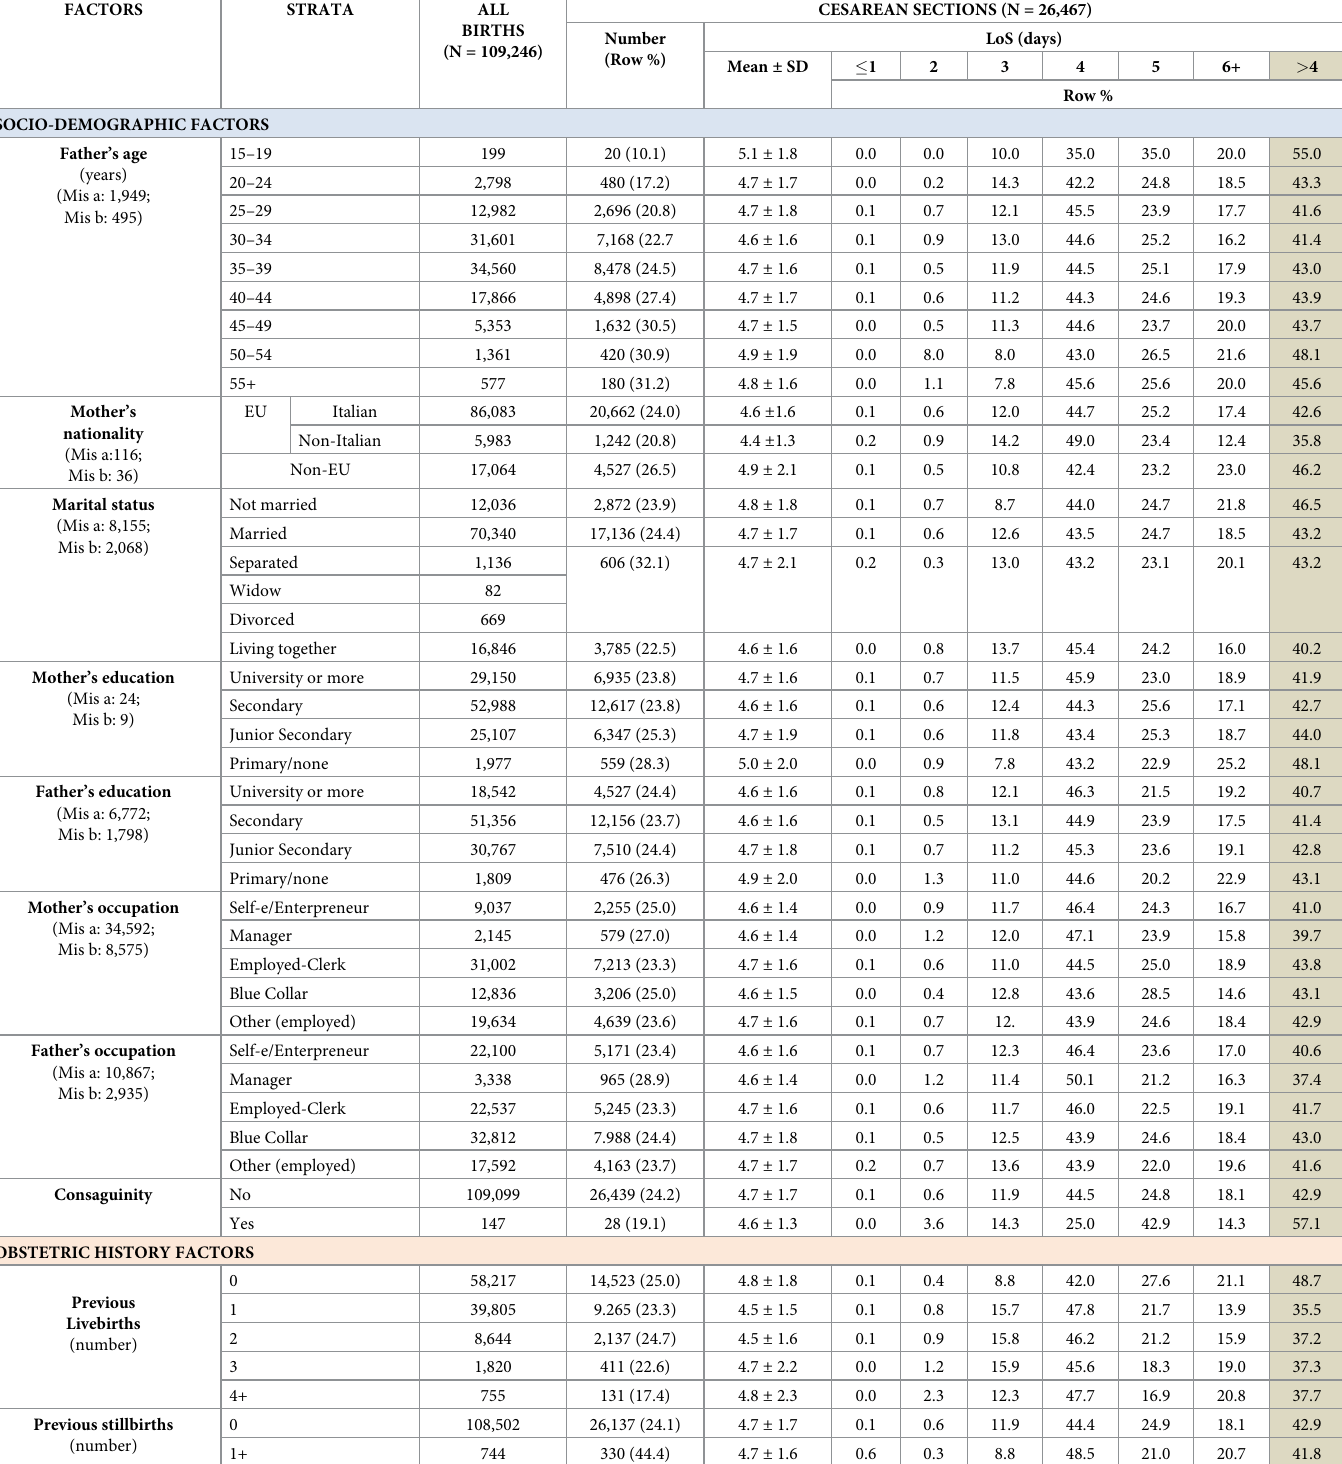
Table 4. Distribution of length of stay (LoS, in days) after cesarean section (CS) by socio demographic and obstetric history factors. Number (N), percentage (%); mean LoS ± standard deviation (SD); Mis a: missing values on all births; Mis b: missing values considering only CS. Self-e = self-employed. FACTORS STRATA ALL BIRTHS